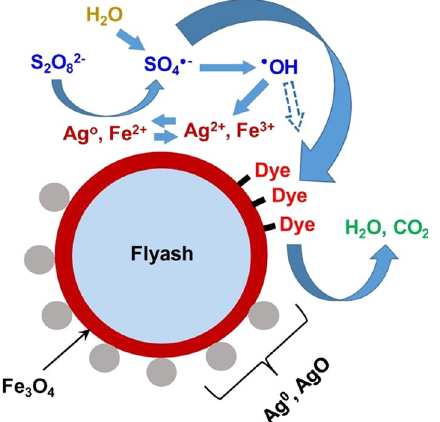
Fig. 24 Catalytic degradation of Corafix Red ME4B dye by fly ash- Fe 3 O 4 -Ag nanocomposite and regeneration of catalyst (Krishnamoor- thy et al. 2021)